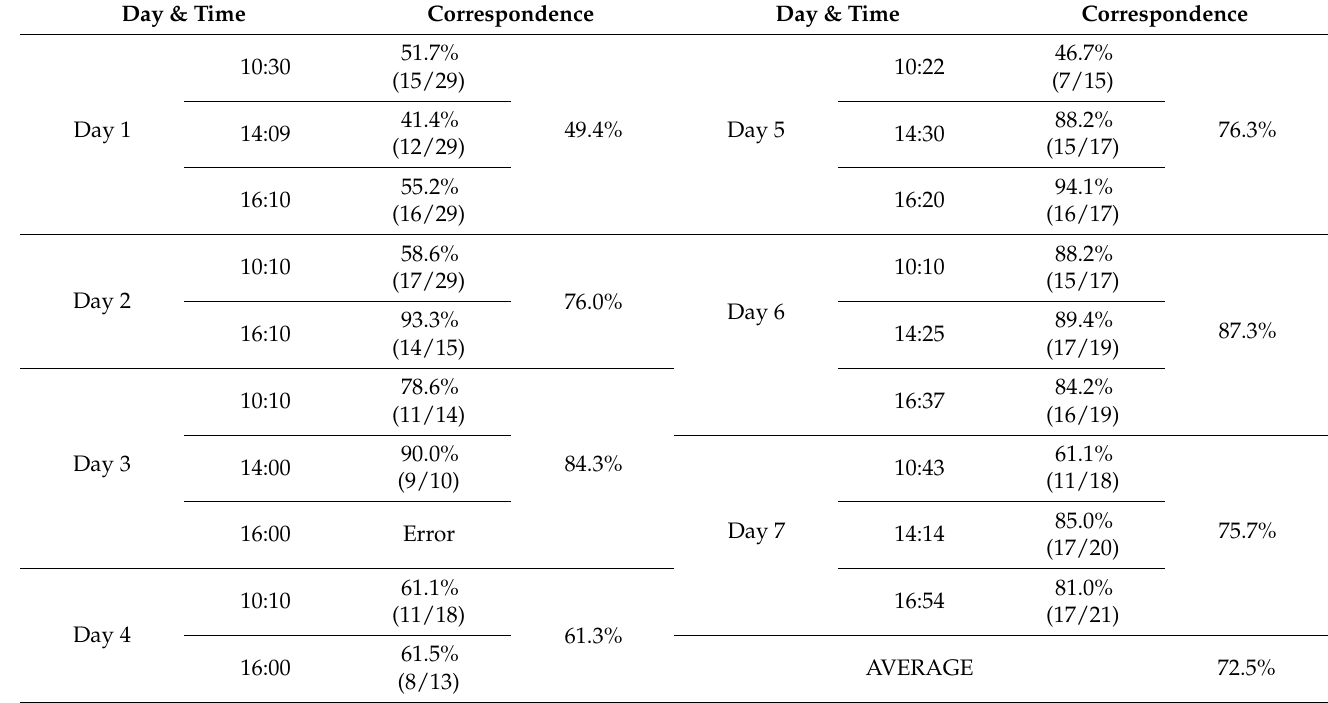
Table 5. Location of Infusion Pumps Using Hospital